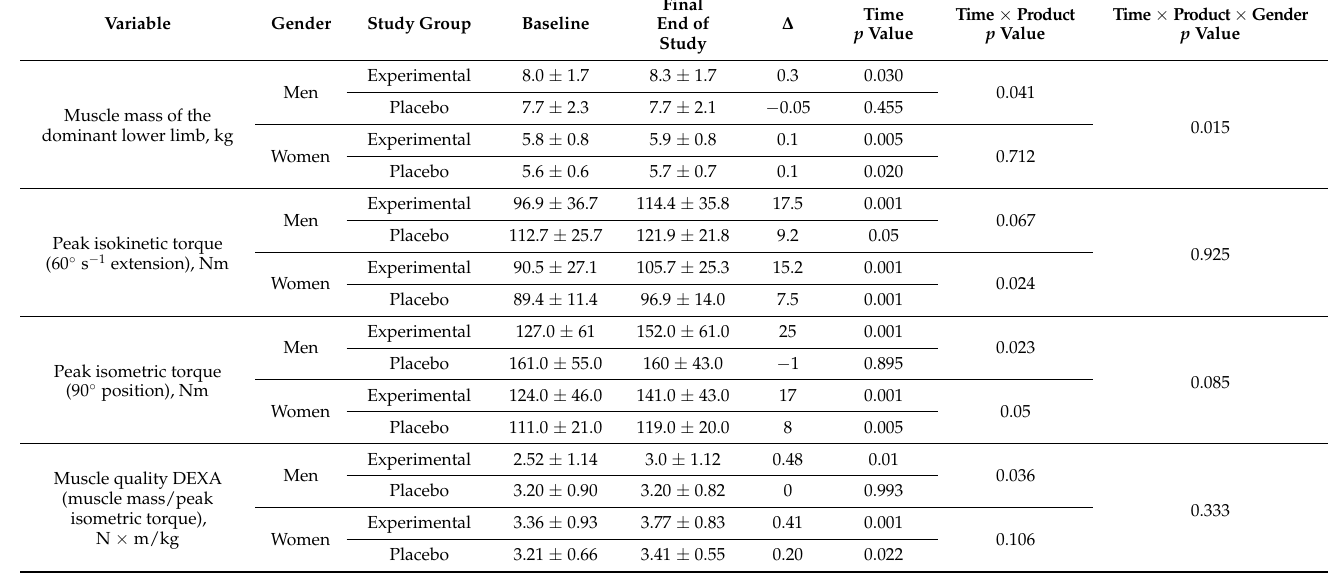
Table 5. Gender differences in gains of muscle mass, strength, and muscle quality at the end of the study after 12 weeks of food supplementation with a spinach extract or